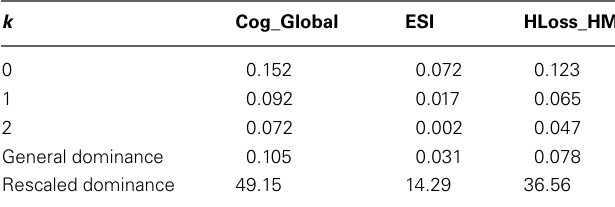
Table 8 | Dominance analysis for prediction of